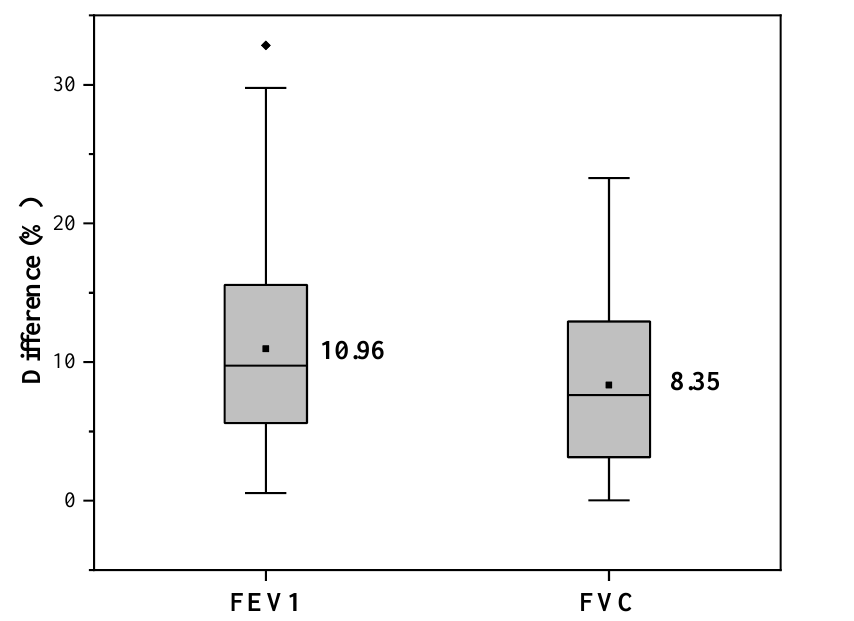
Figure 13. Box plot of error percentages of combination algorithm.